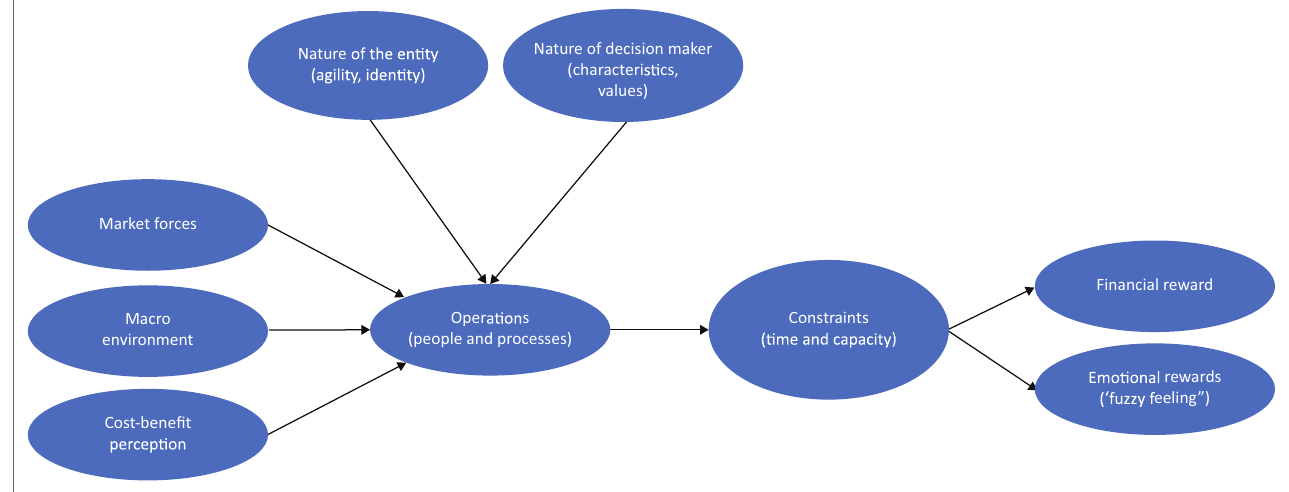
FIGURE 3: Factors influencing strategic decision-making in small-, medium- and